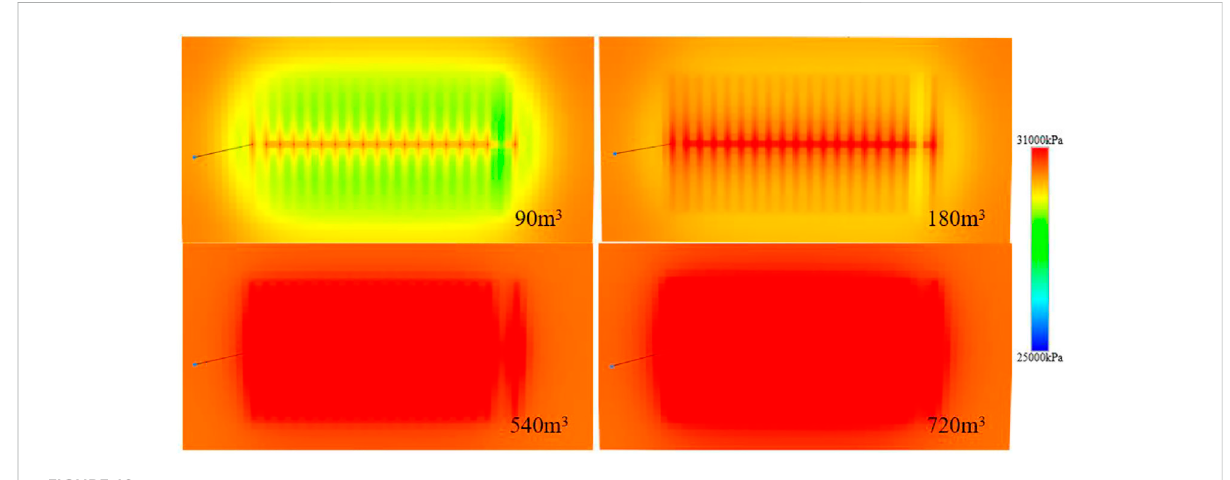
FIGURE 19 Cumulative oil production and bottomhole pressure in late development rounds under different water injection